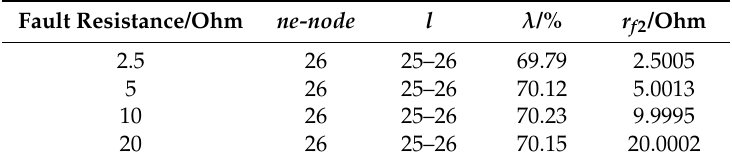
Table 16. Locating results of Strategy 1 with different fault resistances for Case 5.